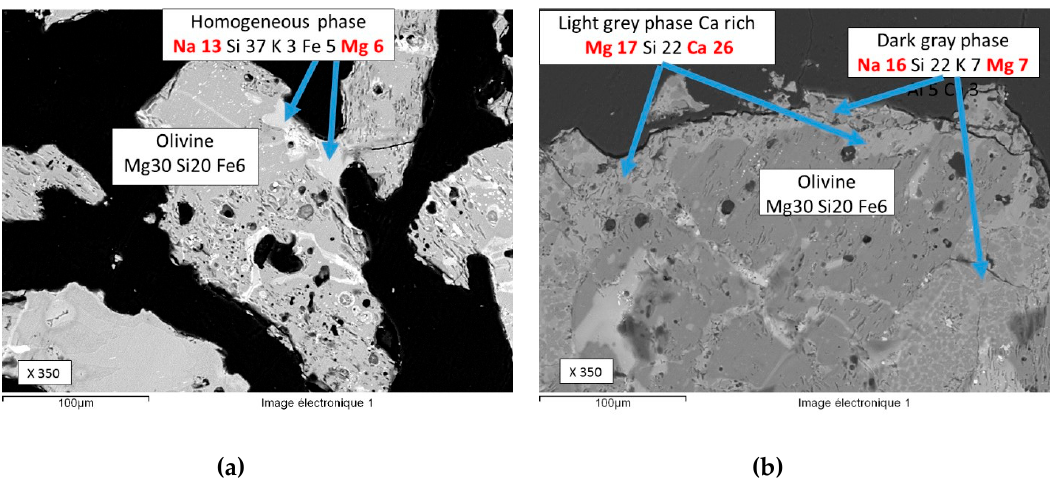
Figure 9. SEM-BSE observations of agglomerates larger than 4.5 mm from lignin residue, ( a ) after fluidised bed gasification, ( b ) after residue combustion.